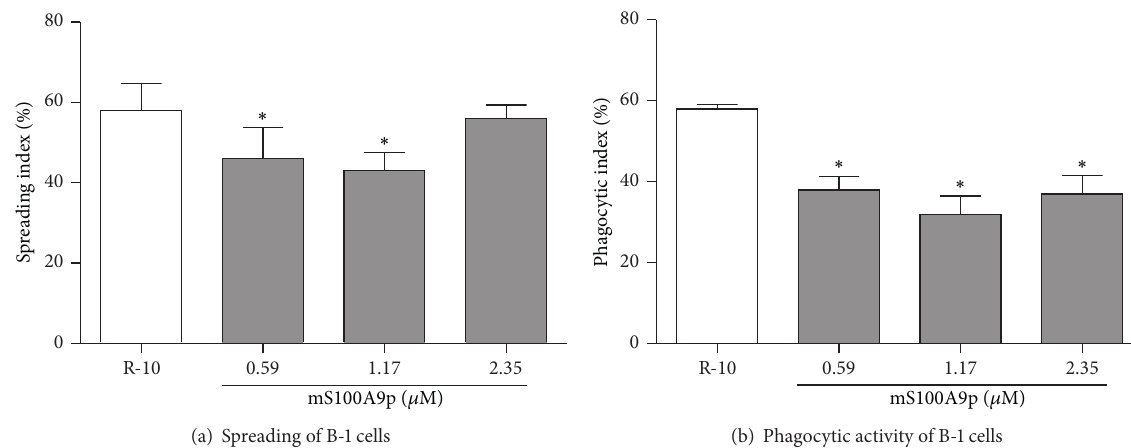
Figure 4: Spreading and phagocytosis assays by B-1 cells after incubation with mS100A9p. (a) B-1 cells, isolated by stationary culture of peritoneal cells obtained from Swiss mice, were adhered per 3 h to coverslips (1 × 10 5 cells/well) and incubated with mS100A9p (0.59; 1.17; or 2.35 𝜇 M in R-10, RPMI-1640 medium containing 10% of heat-inactivated fetal bovine serum, R-10), for 24 h at 37 ∘ C in 5% CO 2 . Control adherent cells were incubated only with R-10. (b) After spreading, cells were incubated with 1 × 10 6 Candida albicans particles for 1h. Results are expressed as means ± SD, using six animals per group. ∗ 𝑃 ≤ 0.05, when compared to the control group (R-10).